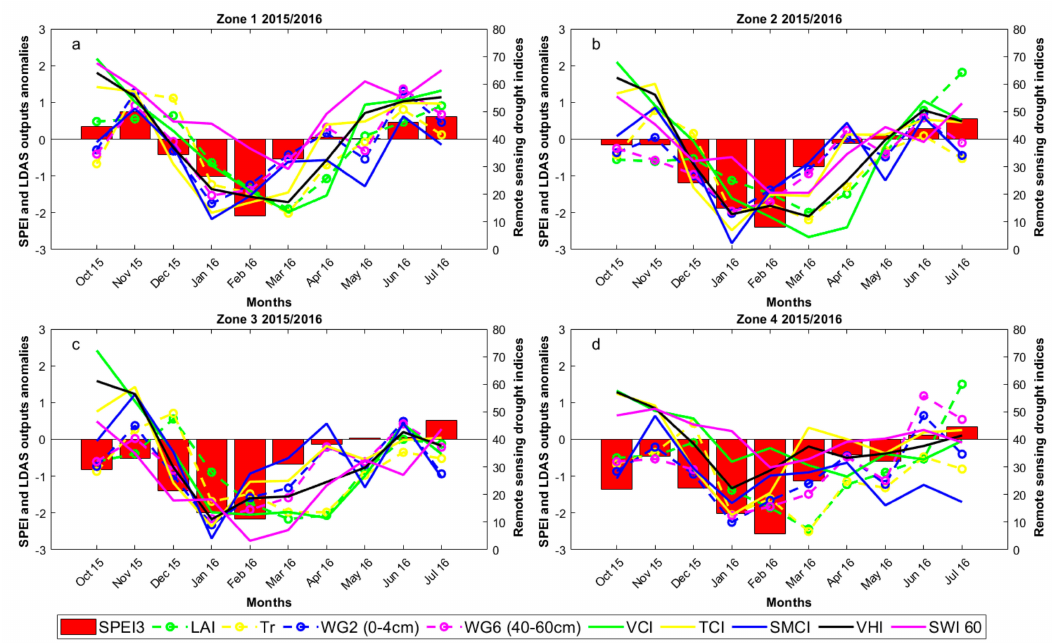
Figure 7. Monthly evolution of the remote sensing drought index anomalies VCI, TCI, VHI, SMCI, SWI60, and LDAS outputs standardized anomalies LAI, Tr, WG2 (0–4 cm), WG6 (40–60 cm) and SPEI3 for zone 1 ( a ), zone 2 ( b ), zone 3 ( c ) and zone 4 ( d ) during the 2015 / 2016 dry cropping